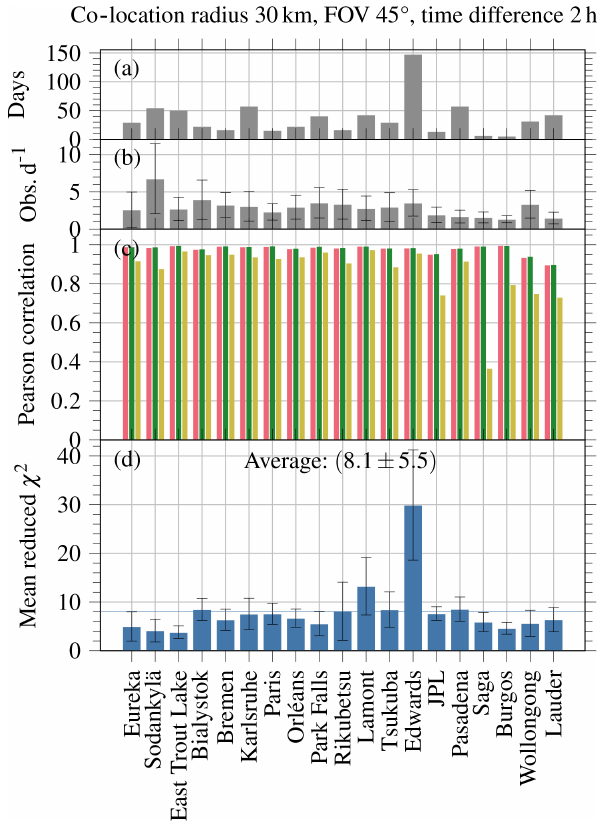
Figure 7. Statistics of the validation for all TCCON stations. (a) Number of days with co-located measurements. (b) Average number of co-located TROPOMI observations per day and its stan- dard deviation. (c) Pearson correlation coefficient for H 2 O (red), HDO (green) and δ D (yellow). (d) Average reduced χ 2 and its stan- dard error; the blue line visualises the average over all